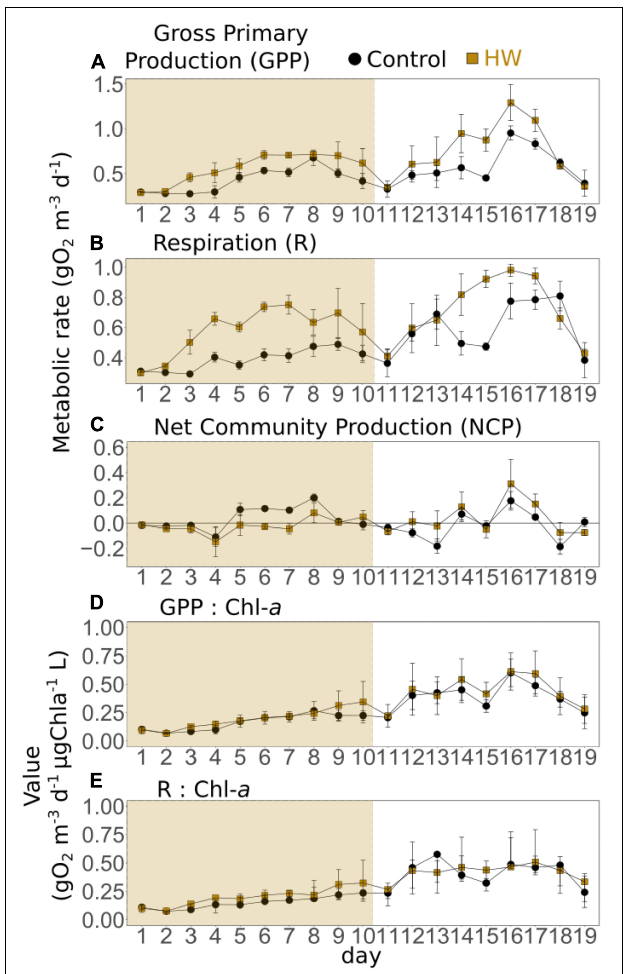
FIGURE 4 | Daily means of gross primary production (GPP, A ), respiration (R, B ), net community production (NCP, C ), GPP normalized by chlorophyll- a fluorescence (D) , and R normalized by chlorophyll- a fluorescence (E) in the control (black) and HW (gold) treatments. The gold shaded area represents the HW period during which the +3 ◦ C was applied in the HW mesocosms. Error bars represent the standard deviation.